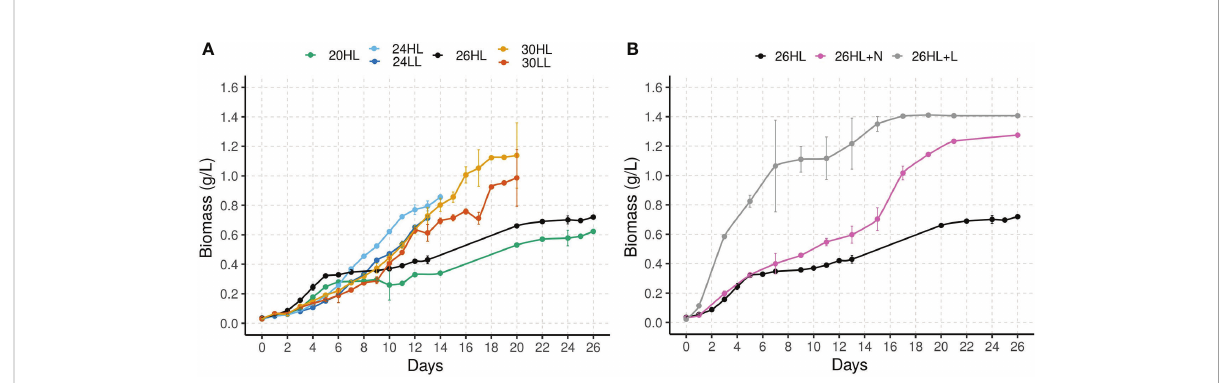
FIGURE 2 Biomass concentration of P. wilhelmii during batch cultivation under (A) 20°C, 24°C, 26°C and 30°C; c(DIN)= 1.3 mmol/L; light levels 130 µmol phot/(m 2 s) and 80 µmol phot/(m 2 s), and (B) at 26°C and 130 µmol phot/(m 2 s); constant light exposure (24:0) and c(DIN)=1.3 mmol/L; Diurnal light exposure (12:12) and c(DIN)=2.6